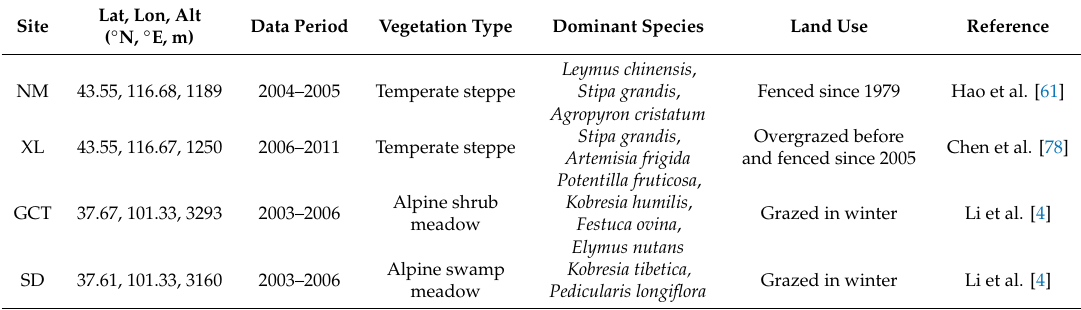
Figure 1. Geographic distribution and characteristics of the four grassland eddy flux tower sites in northern China. Table 2. General information on the four grassland eddy flux tower sites in northern China.